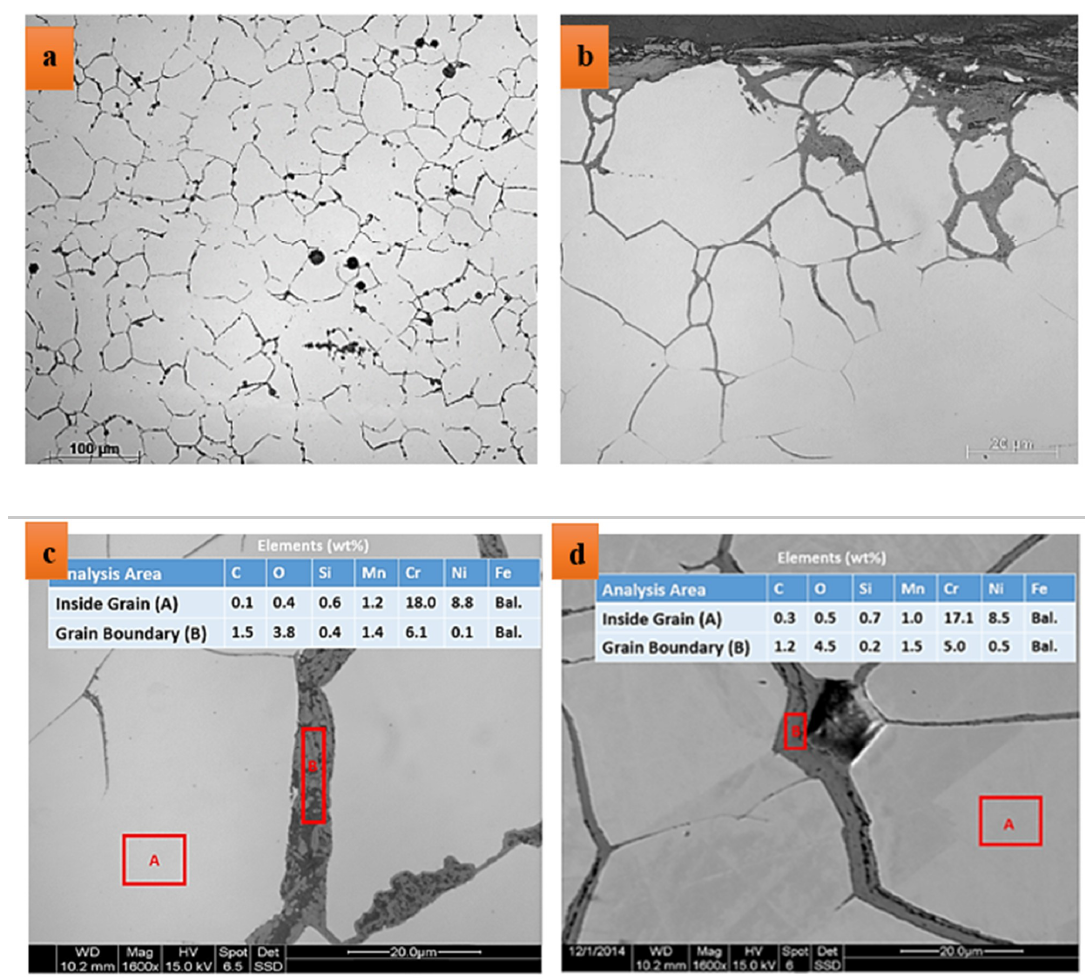
Figure 3. Optical microscope images of grain structure in the heat affected zone (HAZ) area of failed specimens; ( a , b ) an overall view, and ( c , d ) SEM/EDS analyses of grain boundary phase and inside grains.